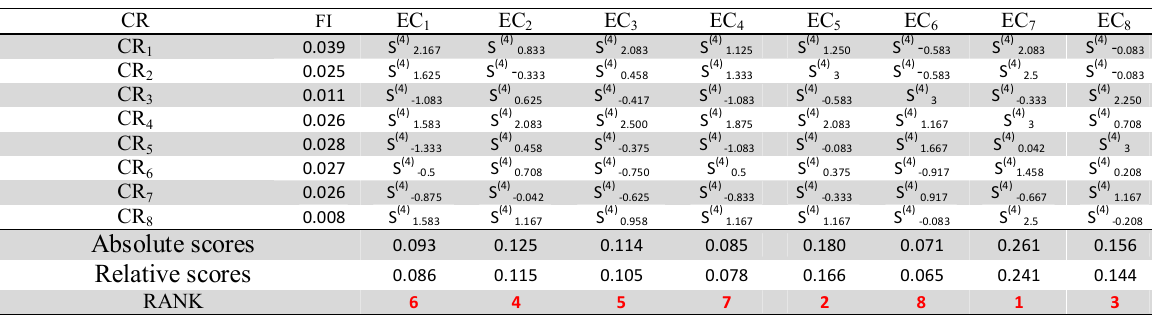
Fig 6. initial House of Quality